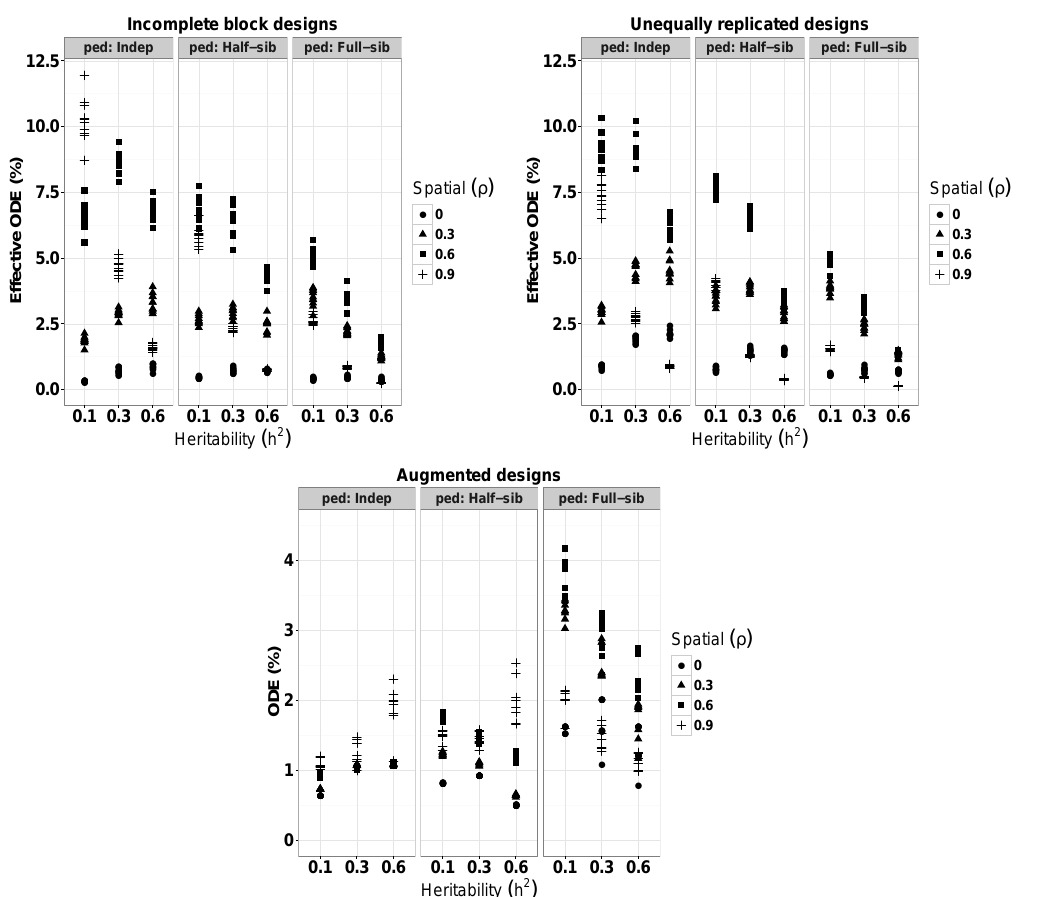
Figure 2. Individual ODE% for incomplete block (IB), augmented block (AB) and unequally replicated (UR) designs. Effective ODE% for IB was obtained after an initial design was subjected to random swapping of genotypes, first across blocks, then either within or across blocks. In contrast, effective ODE% for UR design was obtained after an initial design was subjected to first, random replacement of genotypes using a list of constraints and second, swapping of genotypes within